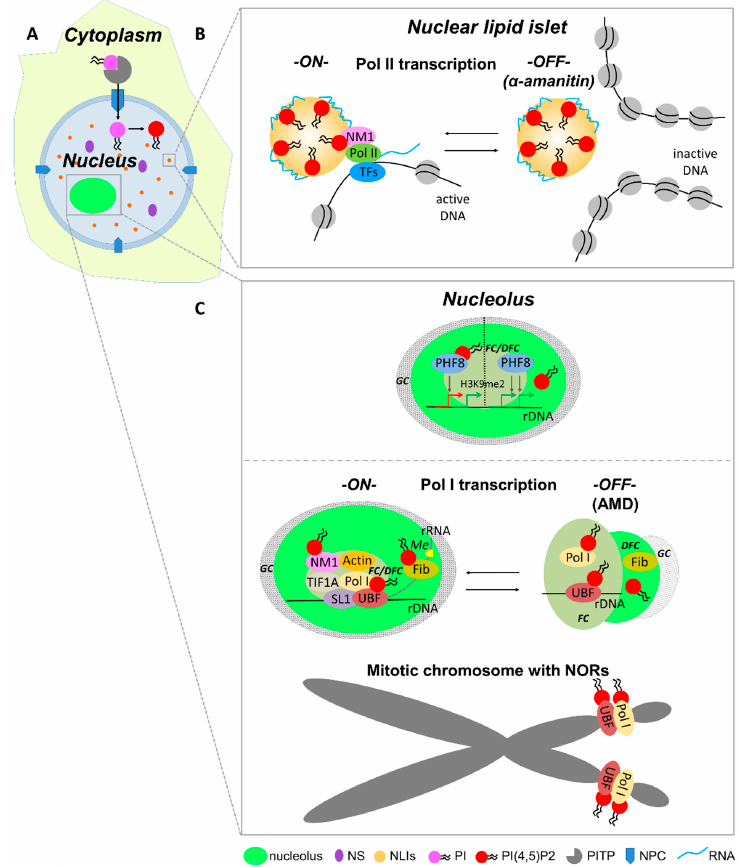
Figure 3. A schematic view of PI(4,5)P2 involvement in RNA pol I and II transcription on the NLI surface and the regulation of nucleolar processes by PI(4,5)P2. Based on published data [11,67,73–75]. ( A ) Phosphatidylinositol (PI) is transported into nucleus together with phosphatidylinositol transfer protein (PITP) and is converted to PI(4,5)P2 via phosphorylation by PI kinases (PIKs) and PI phosphate kinases (PIPKs). ( B ) PI(4,5)P2 is the major component of NLIs, where it may serve as an anchor for the assembly of transcription complexes. PI(4,5)P2 plays a role in promoting RNA pol II transcription together with transcription factor NM1. Upon inhibition of RNA pol II transcription via α -amanitin, the pattern and quantity of NLIs do not change, implying a role for NLIs as a structural platform for the transcription factories. ( C ) In the nucleolus, PI(4,5)P2 directly interacts with PHF8 and represses its function as H3K9me2 demethylase. The PI(4,5)P2-binding mutant of PHF8 has increased activity on ribosomal DNA (rDNA) promoter, which leads to the increased expression of rDNA. Also, PI(4,5)P2 is present at the promoter of RNA pol I, and depletion of PI(4,5)P2 leads to a significant decrease in transcription level. PI(4,5)P2 binds to upstream binding factor of RNA pol I (UBF) and fibrillarin in the fibrillar center (FC) and dense fibrillar component (DFC), respectively. Inhibition of RNA pol I transcription via drugs results in disassociation of PI(4,5)P2 from fibrillarin in the DFC; however, PI(4,5)P2 colocalizes with UBF and RNA pol I in the FC regardless of active transcription. Moreover, during mitosis, when the transcription is switched o ff , PI(4,5)P2 preserves its association with UBF and RNA pol I in nucleolar organizing regions (NORs). This suggests a structural role for PI(4,5)P2 in the formation and / or maintenance of core helix of NORs. FC—fibrillar